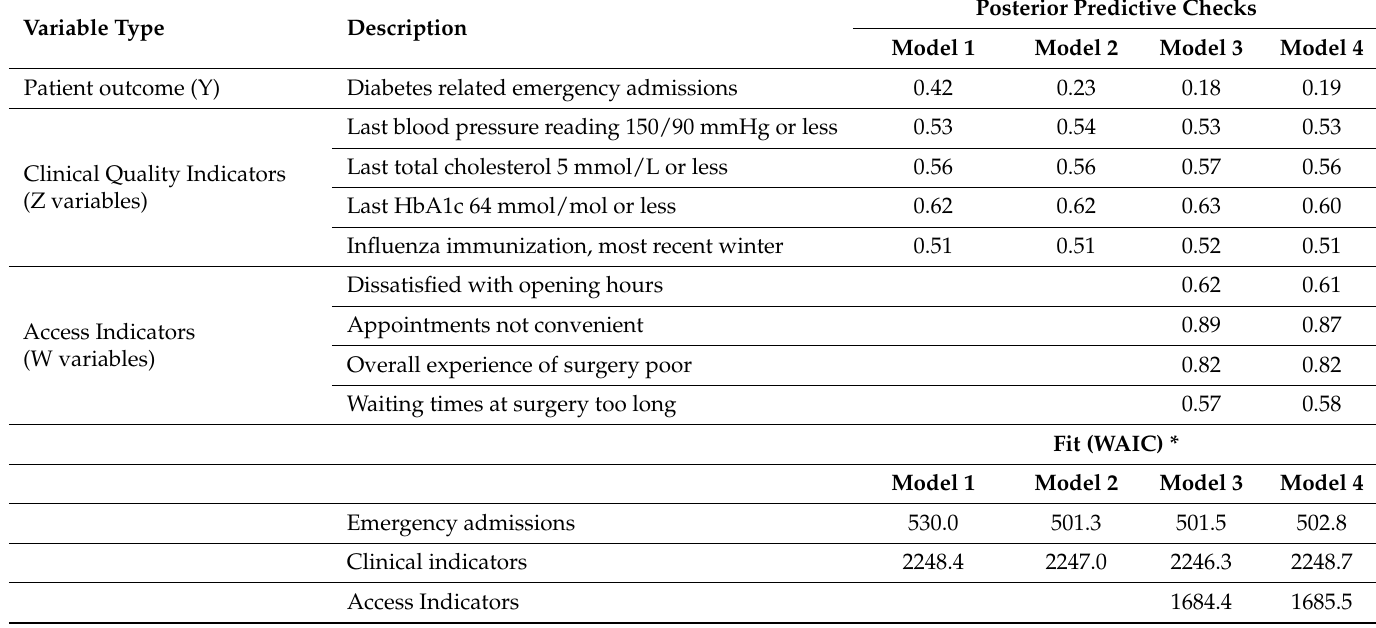
Table 2. Model checks and fit